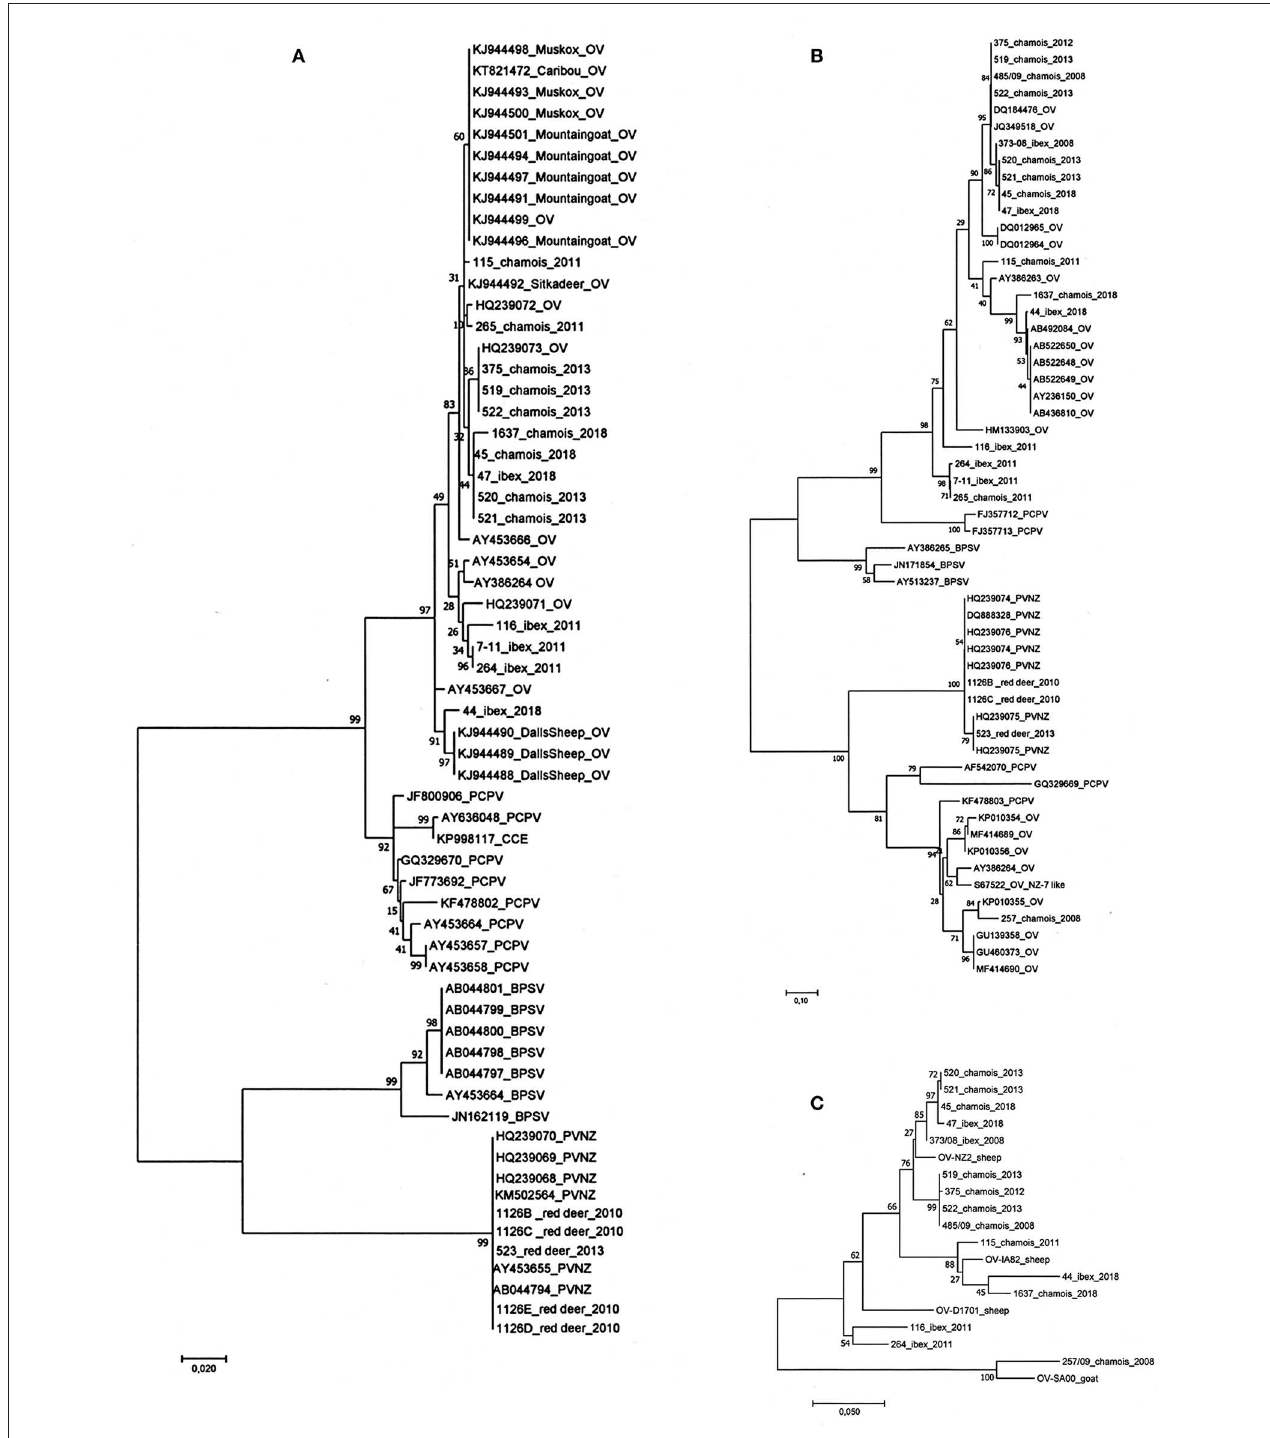
FIGURE 3 | Phylogenetic analysis performed on the parapoxvirus genes sequenced. (A) The phylogenetic tree of the partial B2L gene of the 22 parapoxvirus samples showing clusters corresponding to the four species of the parapoxvirus genus, all the OV sequences from ibex and chamois cluster with other strains isolated from sheep and goats. Five PVNZ isolates grouped into a separate cluster with other PVNZ. (B) The phylogenetic analysis of the vVEGF showed an expected high variability of the vVEGF variant of isolates from chamois and ibex. The chamois sample 257 grouped with the OV NZ7 like vVEGF variants. (C) Phylogenetic tree based on the concatenated B2L, GIF, vVEGF, and vIL10 amino acid sequences. No host-dependent clustering was identified instead two main clusters of NZ2 and NZ7 OV variants. (OV-NZ-2: GenBank n. DQ184476 OV-IA82 GenBank n. AY386263 D1701 GenBank n. HM133903 OV-SA00 GenBank n. AY386264).